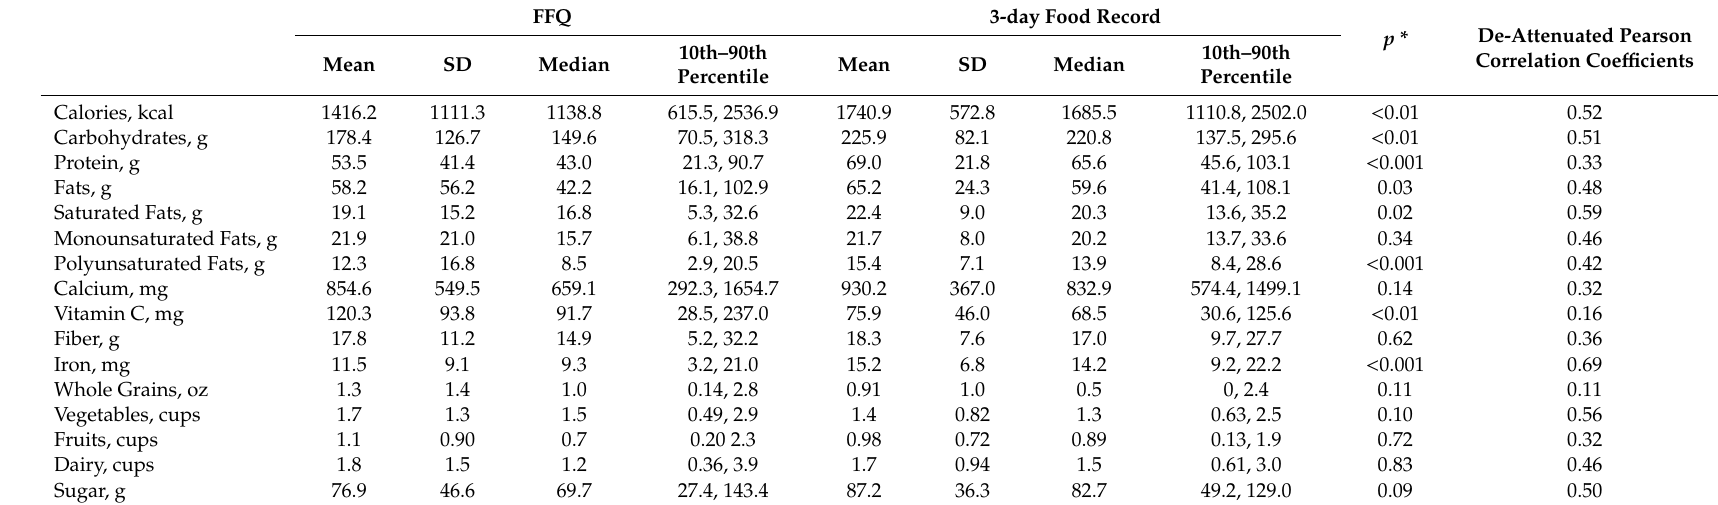
Table 2. Descriptive comparisons of nutrient and food group intakes estimated by the VioScreen food frequency questionnaire (FFQ) and 3-day dietary records among participants of the pilot study ( n =